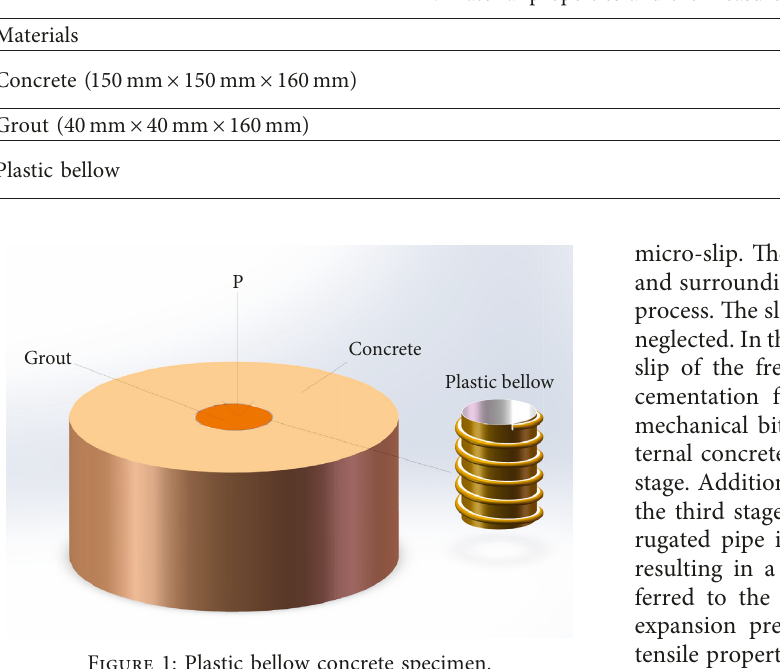
Table 1: Material properties and the measured results.